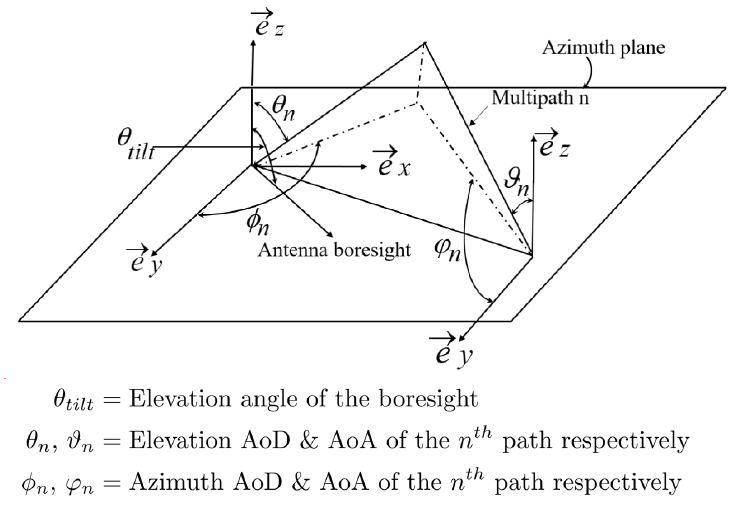
Figure 4. 3D channel